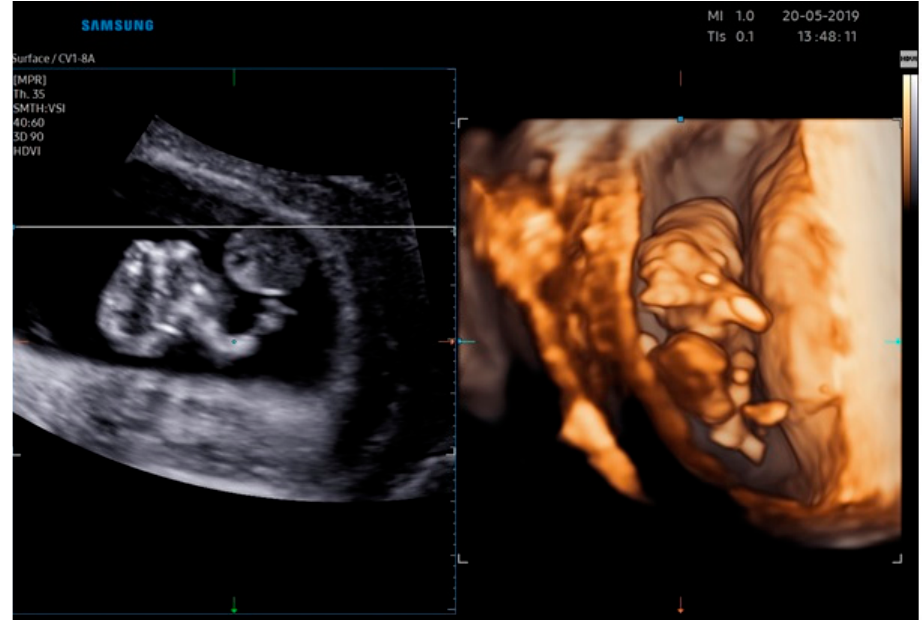
Figure 3. Realistic Vue image of case report 2 at 13 weeks.